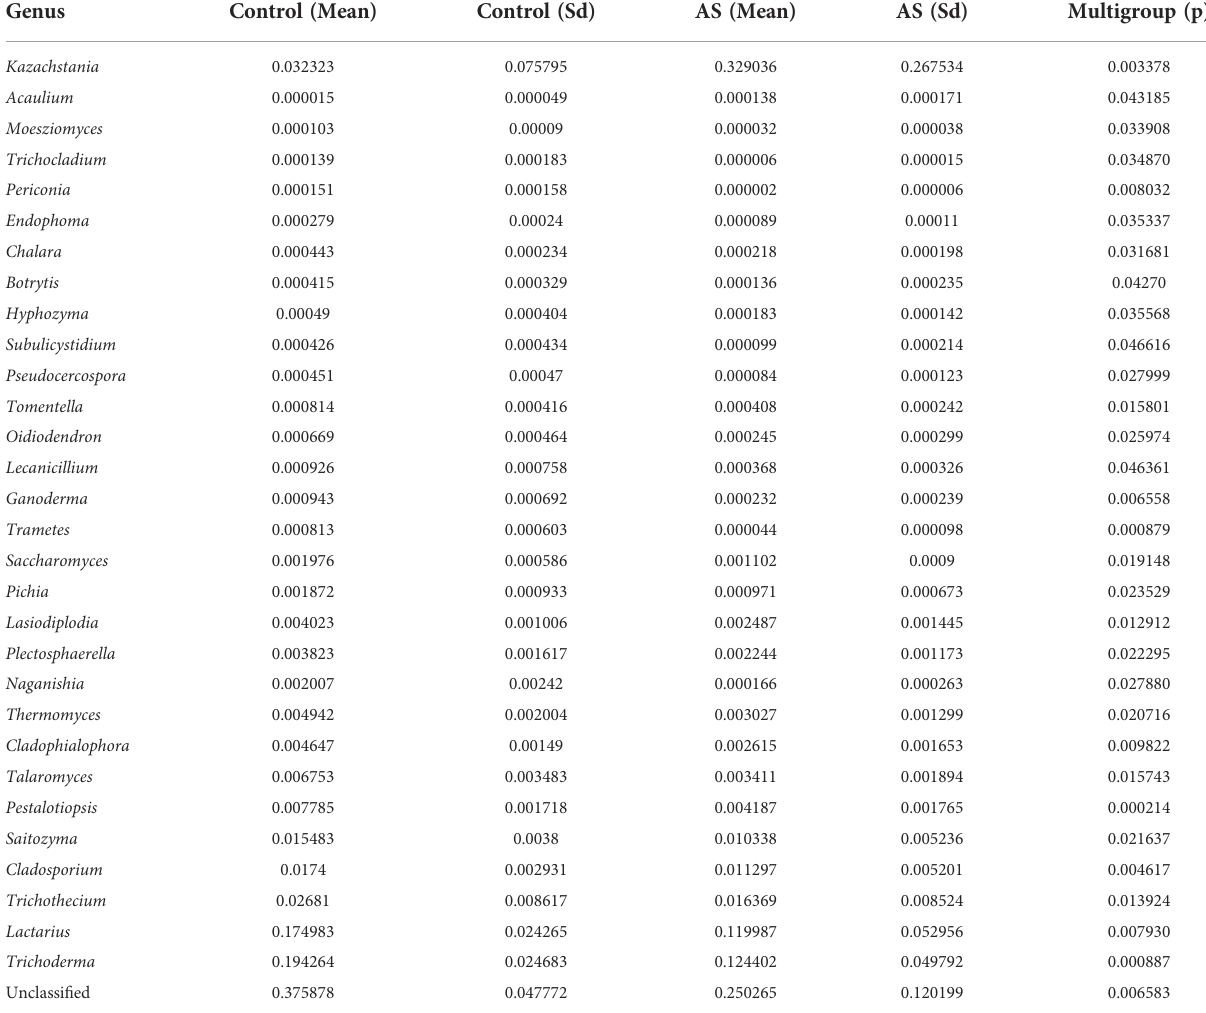
TABLE 2 ANOVA (Analysis of Variance) at genus level of mycobiota of Cynomolgus macaques ( p <0.05).